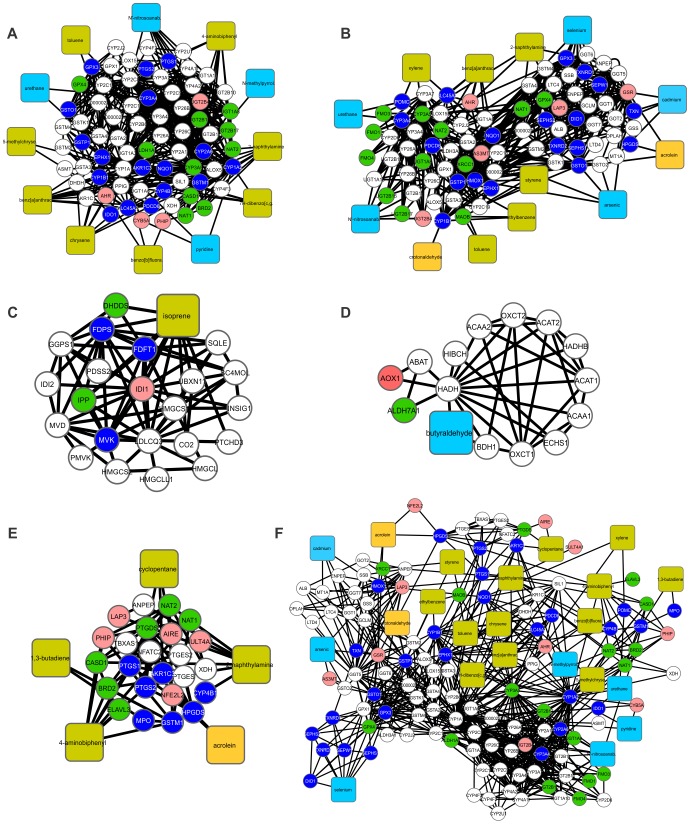
Cluster analysis of the major CPI-PPI network indicating clusters 1, 4, 11, 16 and 20.Cluster 1 (A) is composed of 83 nodes and 565 edges, with Ci = 6,843. The associated hydrophilic constituents are urethane, N-nitrosoanabasine, N-methylpyrrolidine and pyridine. The lipophilic constituents are toluene, 4-aminobiphenyl, 5-methylcrysene, benz[a]anthracene, chrysene, benzo[b]fluoranthene, 7H-dibenzo[c,g]carbazole and 2-naphthylamine. Related GO terms: oxidation reduction and unsaturated fatty acid metabolic processes. Cluster 4 (B) is composed of 90 nodes and 411 edges, with Ci = 4,567. The associated hydrophilic compounds are urethane, N-nitrosoanabasine, N-methylpyrrolidine, arsenic, selenium and cadmium, and the lipophilic compounds are acrolein, crotonaldehyde, toluene, xylene, ethylbenzene, benz[a]anthracene, styrene and 2-naphthylamine. Related GO term: oxidation reduction. Cluster 11 (C) is composed of 23 nodes and 74 edges, with Ci = 3,217. Only the lipophilic compound isoprene is present in this cluster. Related GO term: steroid biosynthetic processes. Cluster 16 (D) is composed of 15 nodes and 36 edges, with Ci = 2,400. The associated hydrophilic compound is butyraldehyde. Related GO term: lipid modification. Cluster 20 (E) is composed of 29 nodes and 65 edges, with Ci = 2,241. The associated lipophilic compounds are acrolein, 2-naphthylamine, 1,3-butadiene, cyclopentane and 4-aminobiphenyl. Related GO terms: prostaglandin metabolic processes and unsaturated fatty acid metabolic processes. A merge of clusters 1, 4 and 20 (F). Clusters 11 and 16 did not show any proteins overlapping with any other cluster.